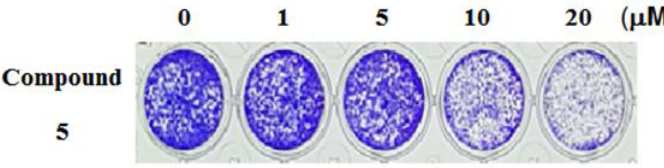
Figure 11. Effect of compound 5 on the inhibition of clonogenicity of HCT116 colon cancer cells.